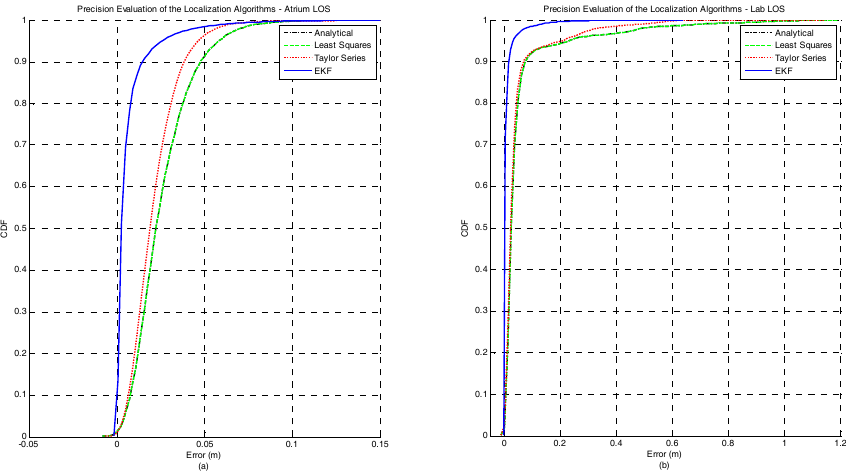
Figure 3. Comparison of the precision achieved by each algorithm for static nodes without human body interference. The localization algorithms were run in two different scenarios: ( a ) atrium and ( b ) lab.